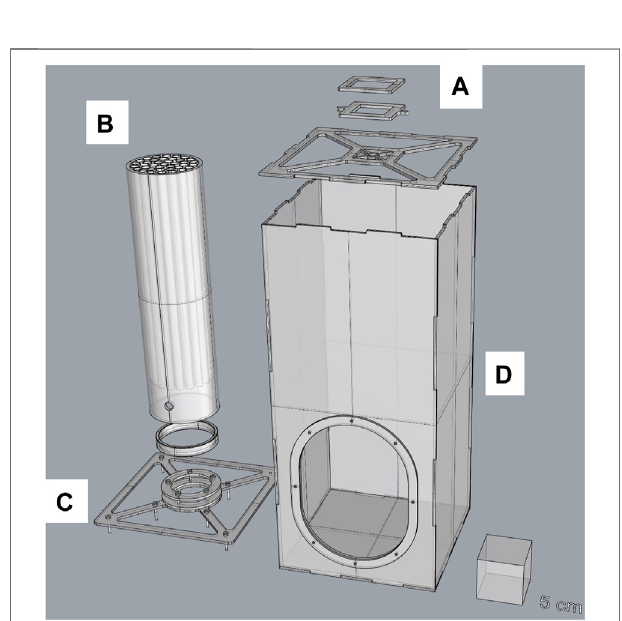
FIGURE 2 | Split design of the new 40-tube fl ight test device (version 1.1). The device comprises a top cover (A) that can hold a fan and BG-Lure pellets, a fl ight test system (inner tube) (B) with 40 individual internal tubes, an inner tube holder (base) (C) , and the main container (containment box) (D) . More details are provided in the technical drawings ( Supplementary Materials S2 – S12